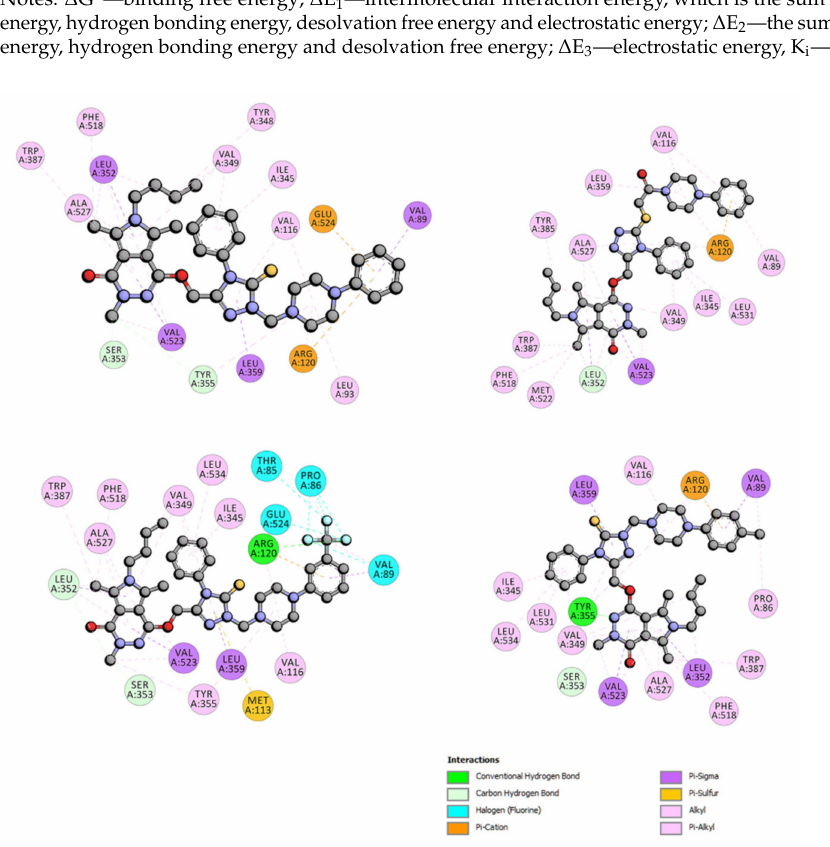
Figure 2. Two-dimensional interaction plot of 4b-7b with